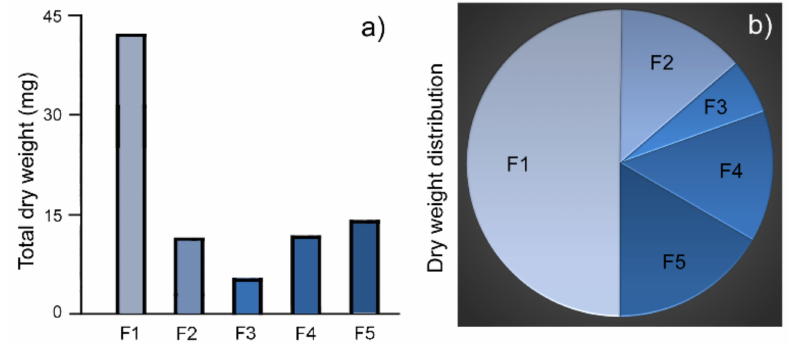
Figure 3. Dry weight of RPE granules. F1 is the most abundant population of RPE granules with the highest total dry weight ( a ). It also accounts for the largest proportion of the weight distribution in the 5 fractions of RPE granules ( b